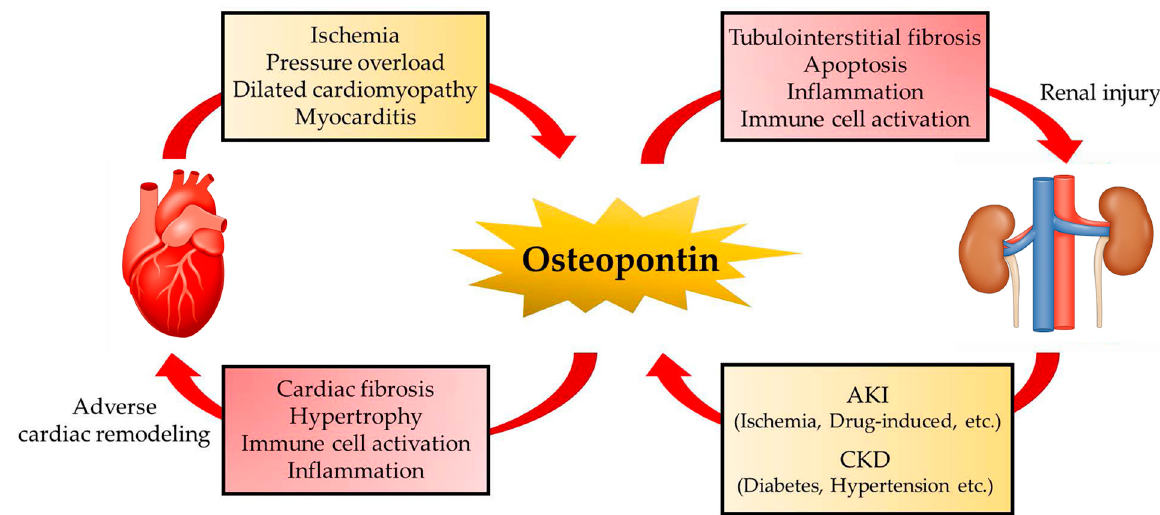
Figure 2. Vicious cycle of OPN in CRS. OPN is involved in the pathogenesis of CRS. Acute or chronic dysfunction of the heart or kidneys can induce OPN expression and may result in acute or chronic dysfunction in the other organ. Several stimuli induce OPN in the pathological conditions of the heart and kidney and OPN causes cardiac fibrosis, cardiac hypertrophy, LV dysfunction, and tubulointerstitial fibrosis.